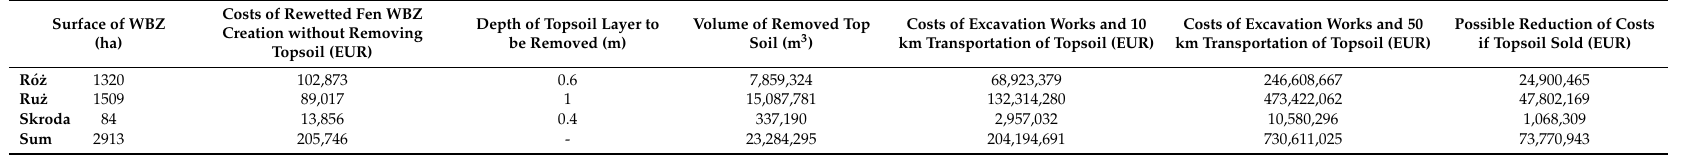
Table 4. Costs of top soil removal in rewetted fen WBZs with high P loss risk after rewetting. Surface of WBZ (ha)